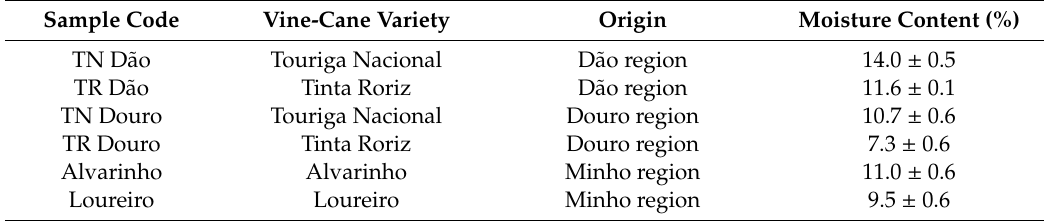
Table 4. Portuguese vine-cane varieties